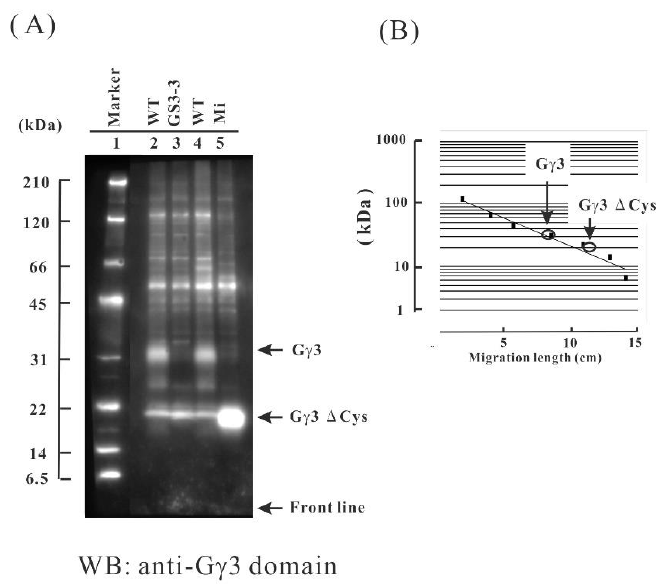
Figure 2. Immunological study of the G γ 3 candidates in the wild-type (WT), Minute ( Mi ), and GS3-3 flowers. ( A ) First, 10 µ g of each protein of the plasma membrane fractions of the WT and GS3-3 and 5 µ g of the protein of the plasma membrane fractions of Mi were used for the Western blot analysis using an anti-G γ 3 domain antibody. Molecular weight marker (lane 1). The G γ 3 candidate was detected as a broad band with a molecular weight of approximately 32 kDa in the WT (lanes 2 and 4). No G γ 3 was detected in GS3-3 (lane 3). The G γ 3 ∆ Cys candidate was detected as a band with a molecular weight of approximately 20 kDa in Mi (lane 5). ( B ) The molecular weights of G γ 3 and G γ 3 ∆ Cys candidates were estimated using a molecular weight marker as a standard.